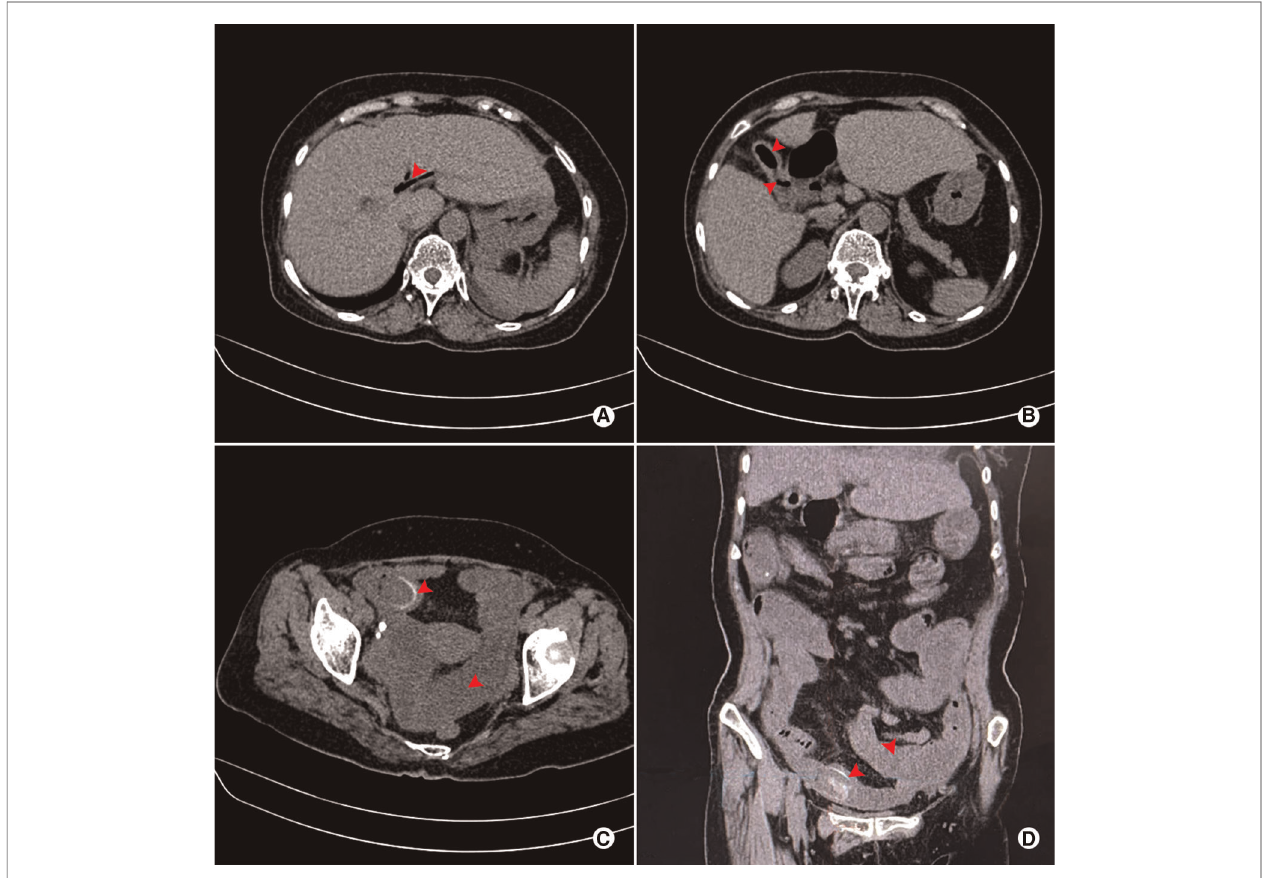
FIGURE 1 | Abdominal plain CT scan of a 71-year-old female patient who was preoperatively diagnosed with CDF combined with GI. (A) Pneumobilia (red arrow); (B) Pneumo-gallbladder and ill-de fi ned borderline between gallbladder and digestive tract (red arrow); (C) Rim-calci fi ed gallstone impacted in the small bowel, combined with dilatation of proximal small bowel (red arrow); (D) Coronal view of impacted rim-calci fi ed gallstone and dilatation of proximal small bowel (red